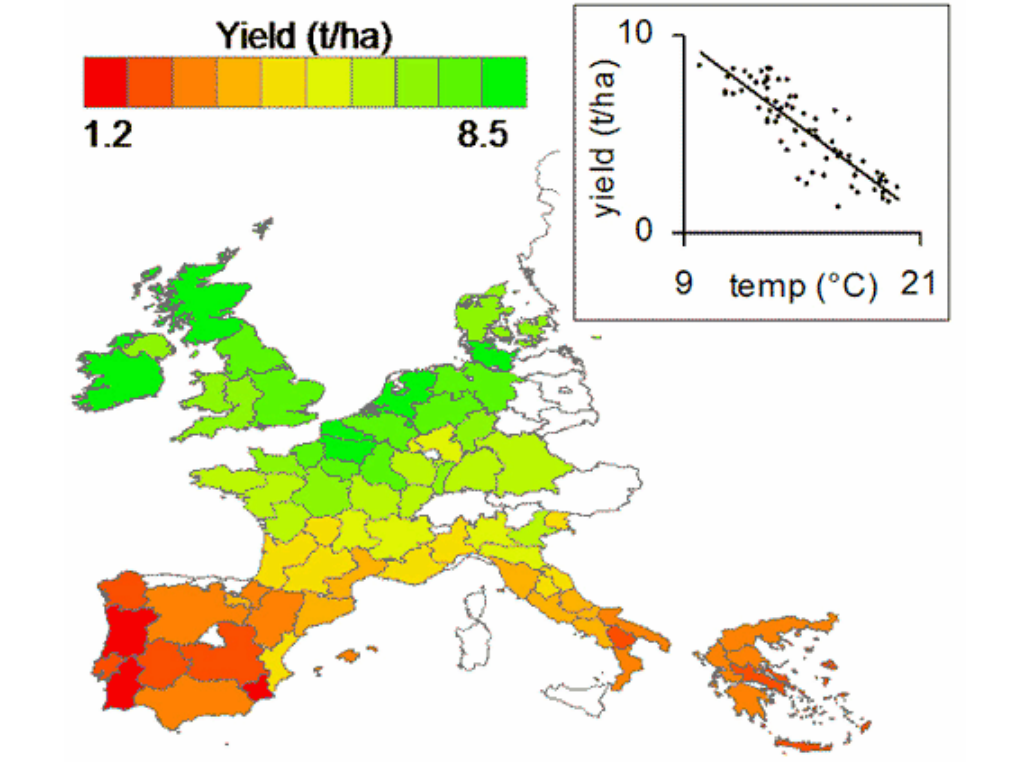
Fig. 1. Spatial distribution of average wheat yields (t/ha), and relationships to average temperature (temp, °C) from 1990–2003. This figure indicates that, spatially, there is a negative relationship between wheat yields and